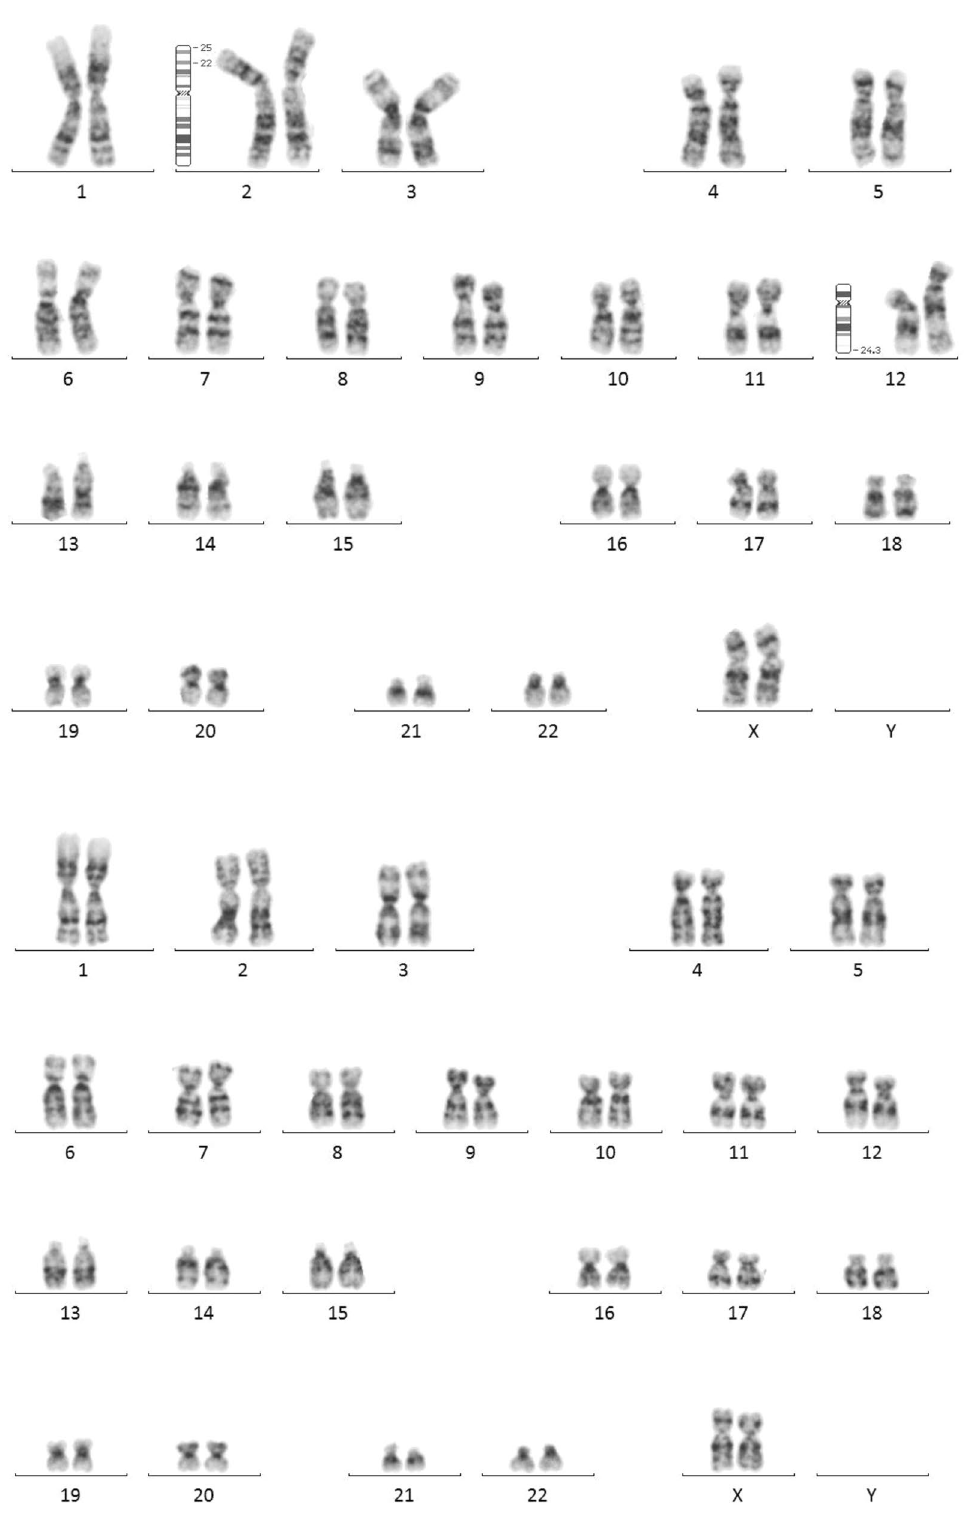
Figure 2. Karyotype of case 13 was 46,XX,der(12)ins(12;2)(q24.3;p22.1p25.3)[33]/46,XX[20] The patient presents a duplication of the short arm of chromosome 2 with breakpoints in bands p22.1 and p25.3 The duplication region was inserted in the long arm of chromosome 12 in band q24.3 in 60% of cells. A similar proportion was obtained by FISH analysis on oral mucosa cells (not